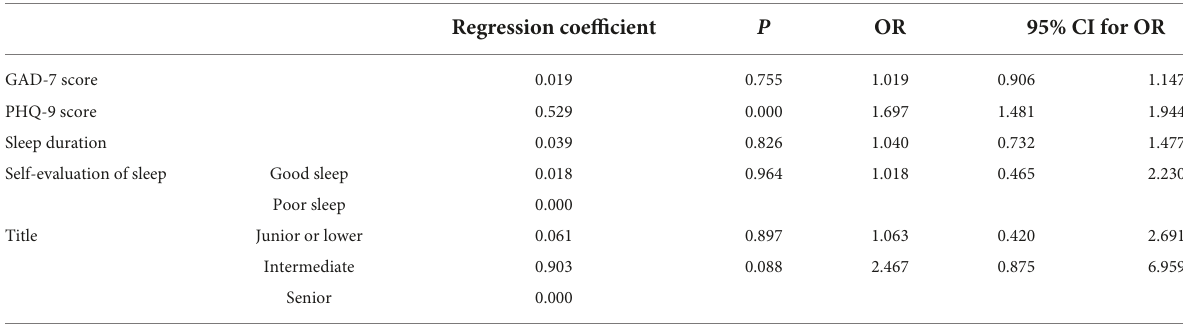
TABLE 4 Binary logistics regression analysis of general fatigue among medical workforce.